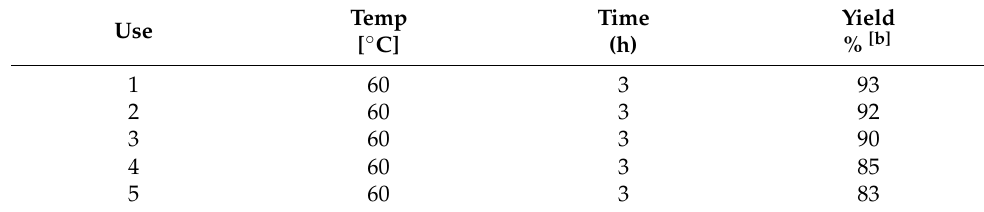
Table 3. Recycling of nano-ZrO 2 for synthesis of 4-OMe benzimidazole ( 3a ) [a]